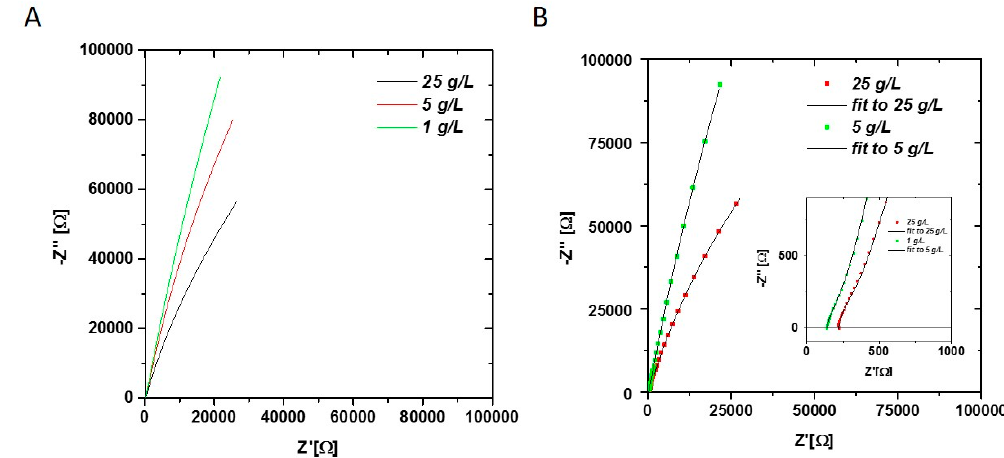
Figure 2. ( A ) Nyquist plot of E. coli samples at different concentrations (1–25 g/L) measured in offline mode. Obvious changes in the double layer are visible at low frequencies; ( B ) Nyquist plot of 1 g/L and 25 g/L sample with fit using equivalent circuit in Equation (1). Fitted parameters all three samples are given in Table 1. The Q value of the CPE dl element is strongly dependent on the biomass concentration.